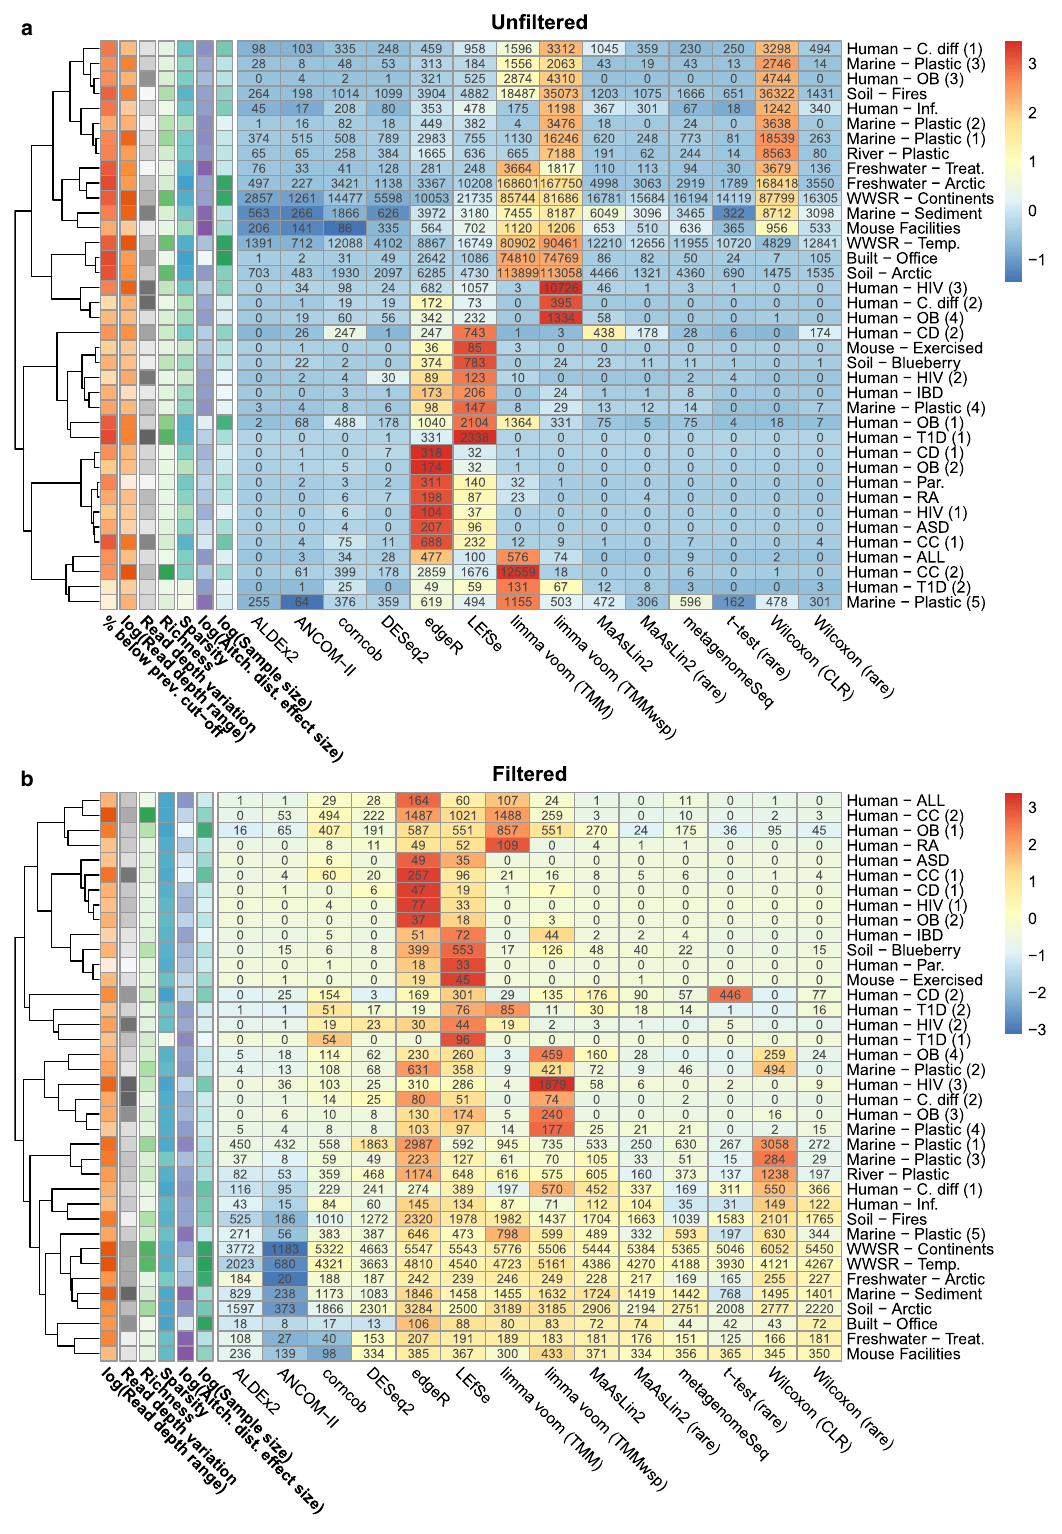
Fig. 1 Variation in the proportion of signi fi cant features depending on the differential abundance method and dataset. Heatmaps indicate the numbers of signi fi cant amplicon sequence variants (ASVs) identi fi ed in each dataset by the corresponding tool based on a un fi ltered data and b 10% prevalence- fi ltered data. Cells are colored based on the standardized (scaled and mean centered) percentage of signi fi cant ASVs for each dataset. Additional colored cells in the left-most six columns indicate the dataset characteristics we hypothesized could be driving variation in these results (darker colors indicate higher values). Datasets were hierarchically clustered based on Euclidean distances using the complete method. Abbreviations: prev., previous; TMM, trimmed mean of M-values; TMMwsp, trimmed mean of M-values with singleton pairing; rare, rare fi ed; CLR, center-log-ratio. Source data are provided as a Source Data fi